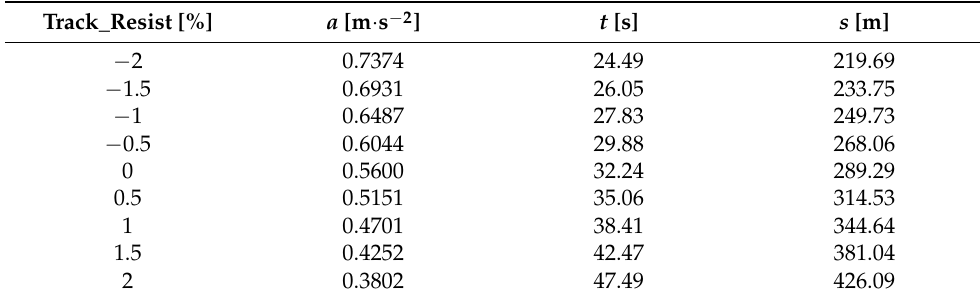
Table 3. Time and length of the braking